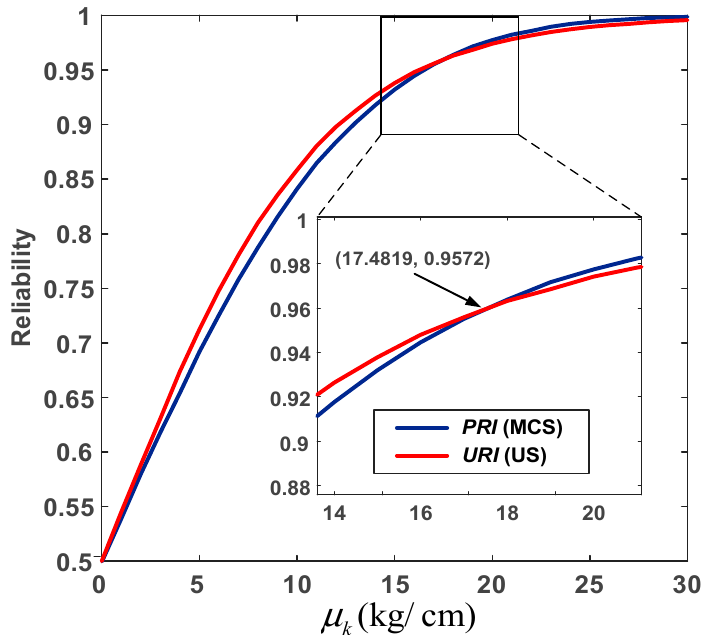
Figure 5. Reliability comparison for the suspension mechanical model.